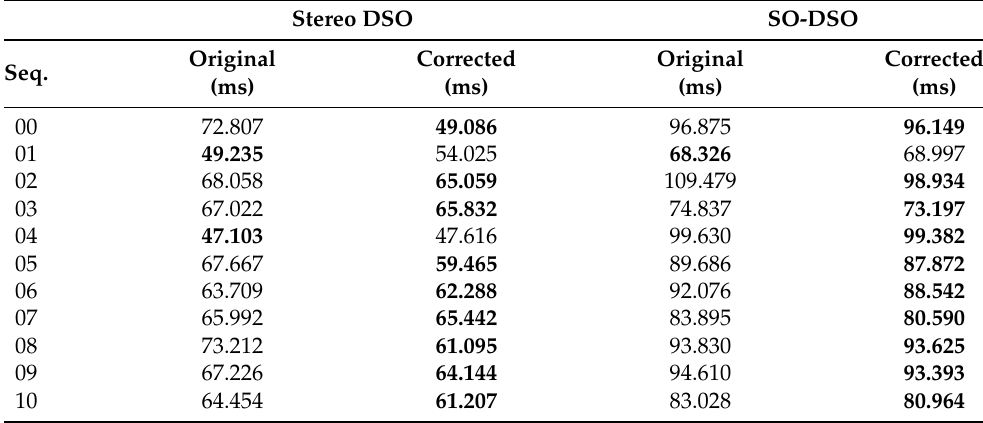
Table 3. Time costs of Stereo DSO and SO-DSO on the original KITTI dataset and the corrected images by the proposed method. Best results are shown in bold type. Stereo DSO SO-DSO